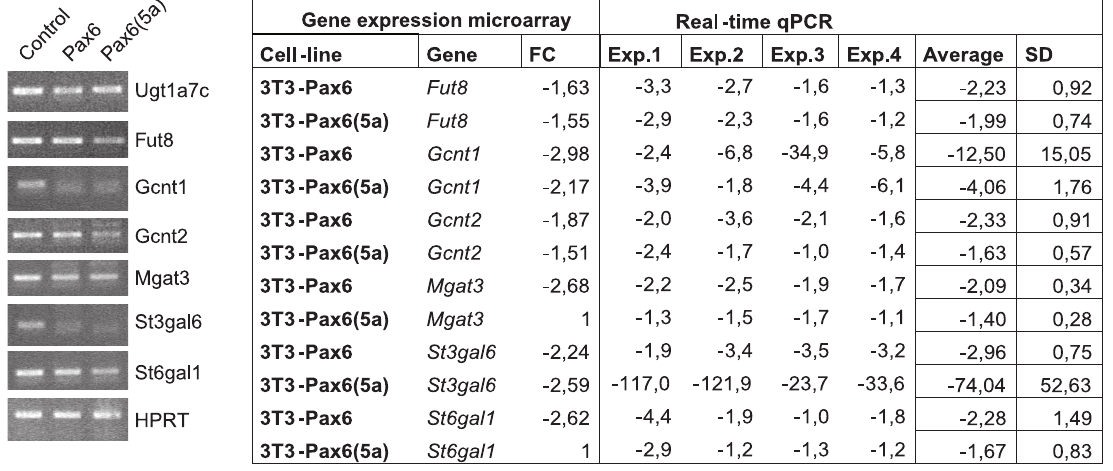
Figure 3. RT-PCR and real time qPCR with primers specific for seven glycosyl transferases confirms that this group of genes is downregulated by both Pax6 and Pax6(5a). Primers were designed against Ugt1a7, Fut8, Gcnt2, St3gal6, St6gal1, Gcnt1 and Mgat3. All showed downregulation of transcription of these genes in both the Pax6 and the Pax6(5a) cell lines compared to the FlpIn-3T3 control cell line. Pictures are representative of three experiments. The fold change value (FC) from the gene expression microarray is included in the table to the right. The Fut8 FC values for Pax6 and Pax6(5a), and the Gcnt2 value for Pax6(5a) have a p-value=0,01(threshold 2), while the rest of the FC values listed have a p-value of 0.001 (threshold1). Four independent real-time qPCR experiments are included (Exp.1-Exp.4), and the results are presented as FC in cDNA concentrations in the FlpIn-3T3 Pax6 and Pax6(5a) cell lines compared to the FlpIn-3T3 control cell line, after normalization against two housekeeping genes (Nono and Tfrc).